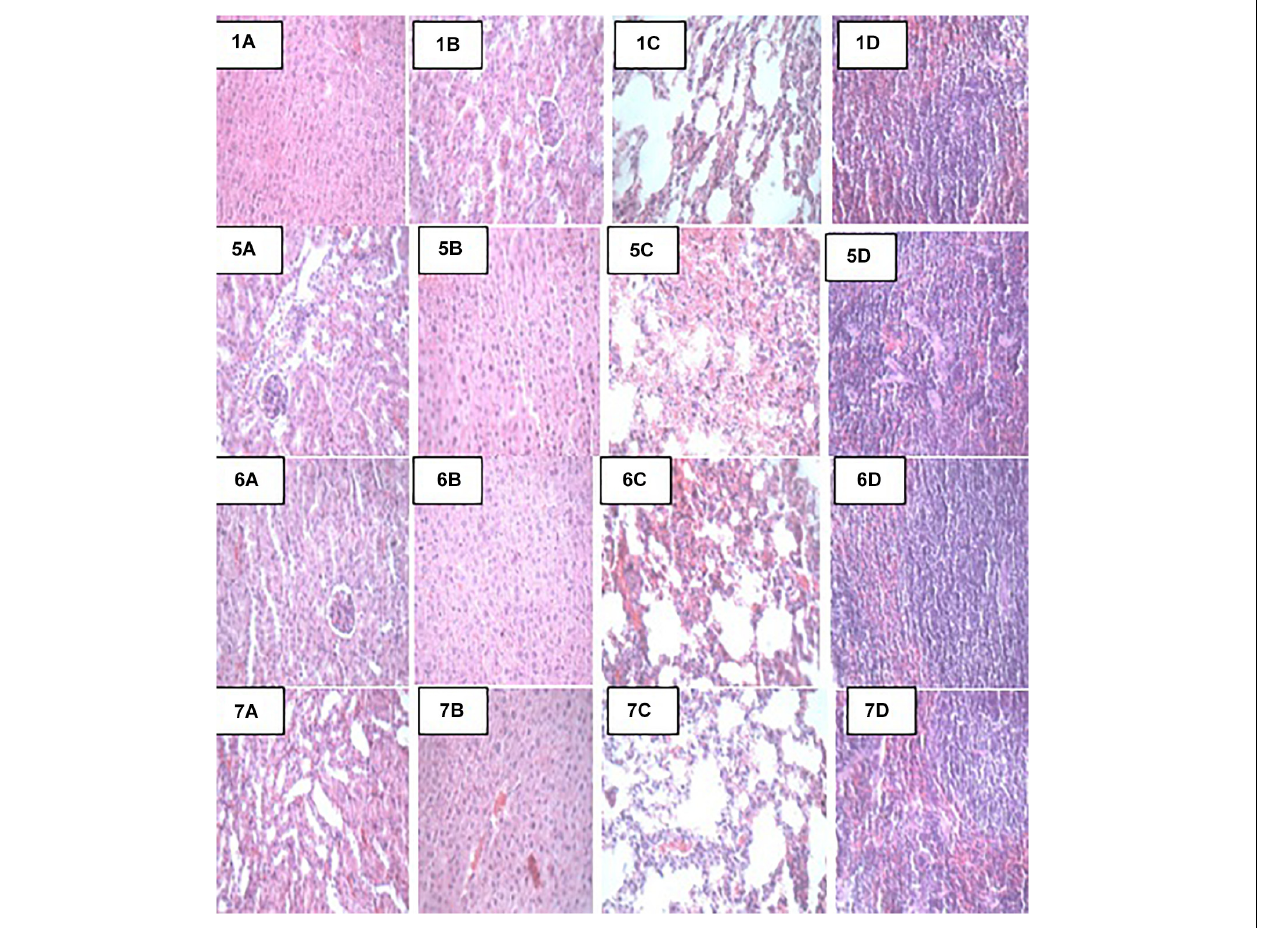
FIGURE 2 | Representative photomicrographs of organs of mice fed Control, T SA , T STSA , and T LBSA diets 1A–1D : Control (Kidney, liver, lung, and spleen, respectively), 5A–5D : T SA (Kidney, liver, lung, and spleen, respectively), 6A–6D : T STSA (Kidney, liver, lung, and spleen, respectively), and 7A–7D : T LBSA (Kidney, liver, lung, and spleen,